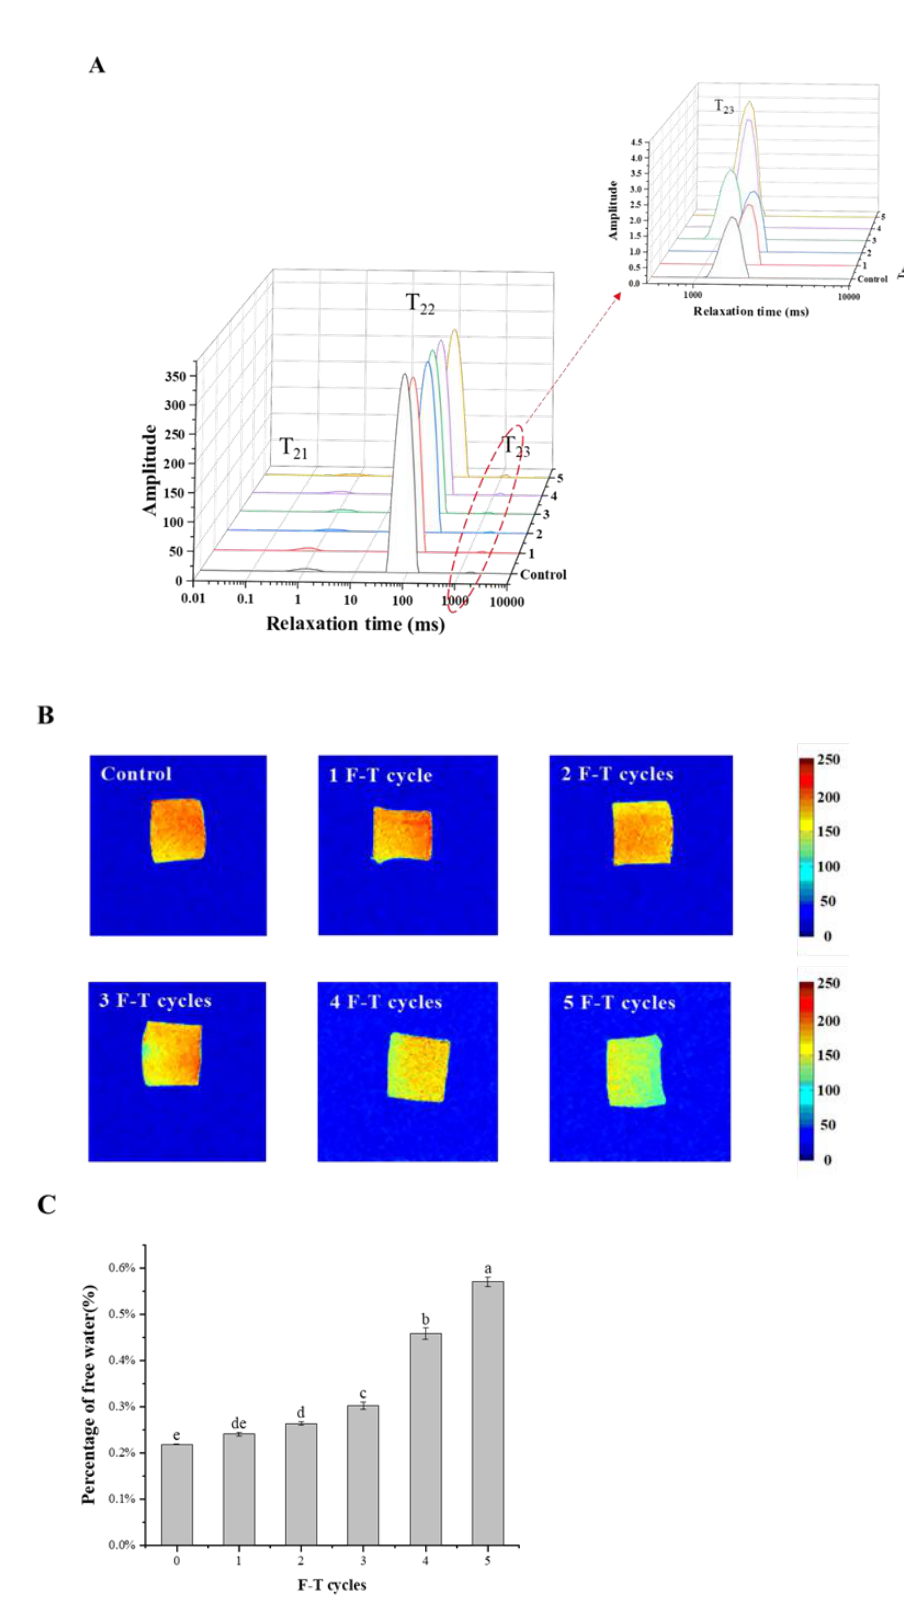
Figure 2. T2 relaxation time distribution of LF-NMR ( A ), magnetic resonance imaging ( B ), percentage of free water content ( C ) of cuttlefish after F-T cycles. Error bars show standard deviation. The letters “a–e” indicate significant differences ( p < 0.05).